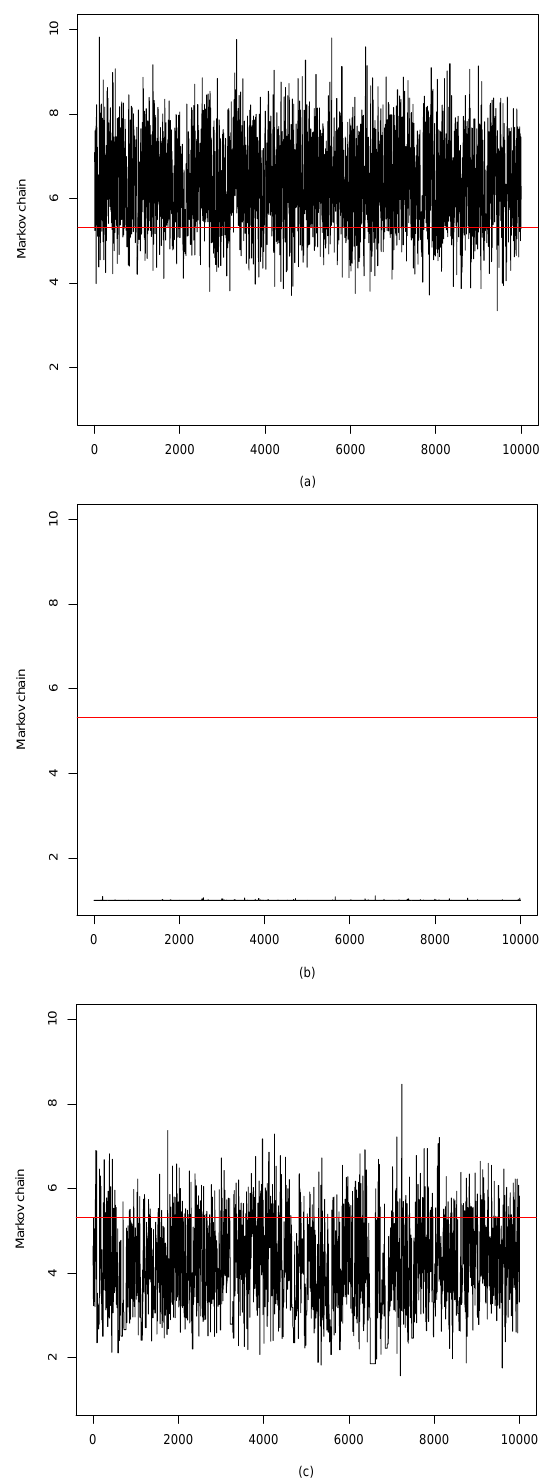
Figure 10. The Markov chain of ˜ b 0 via using ( a ) domain I, ( b ) domain II, and ( c ) domain III: The straight line is the true value of b 0